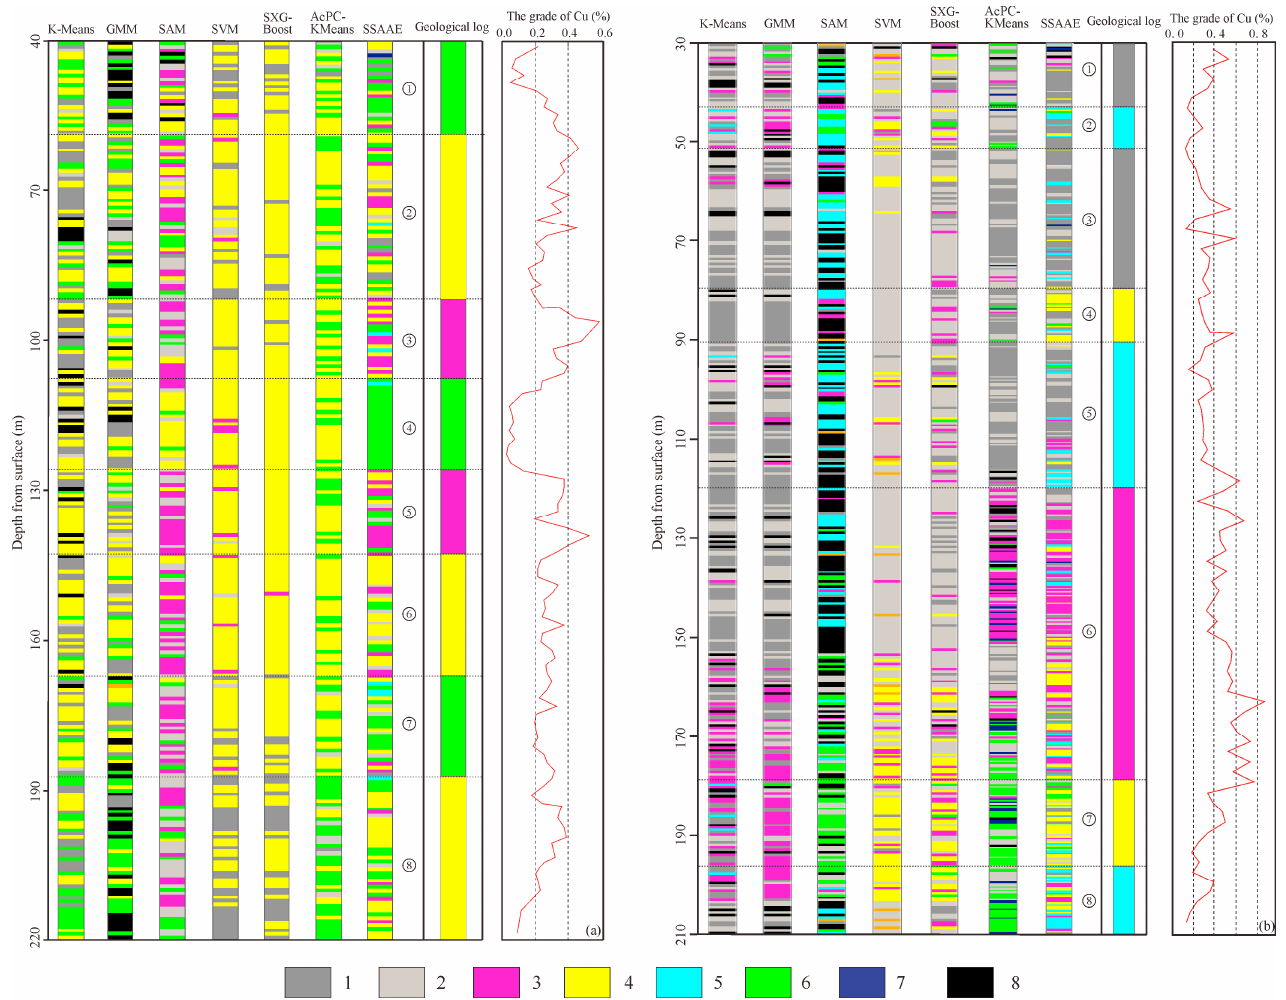
Figure 13. Comparison of classification results using different methods under the measured hyper- spectral dataset of drilling cores of Pulang copper mine. ( a ) ZK0113; ( b ) ZK0307. 1—Quartz monzonite porphyry; 2—Silification; 3—Potassification; 4—Sericitization; 5—Epidotization; 6—Chloritization; 7—Hornfels; 8—Others.